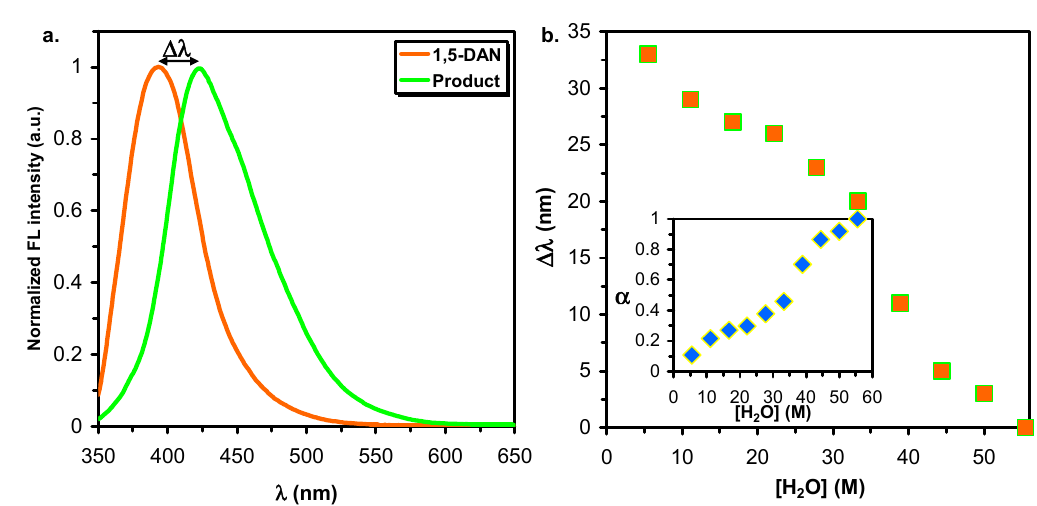
Figure 5. The normalized fluorescence (FL) spectra ( a ) and the difference ( Δλ )* in the emission maxima of 1,5-DAN and that of the product(s) formed in the reaction of 1,5-ICAN in the mixture of EtOH/water and HgCl 2 ( b ). The inset shows the variation of the α values with the water concentration in the water/EtOH mixture. Experimental conditions: [1,5-ICAN] = 2.5 × 10 − 6 mol/L, [HgCl 2 ] = 1.2 × 10 − 3 mol/L and T = 25 °C. * The Δλ values indicated were obtained using the same solvent composition .